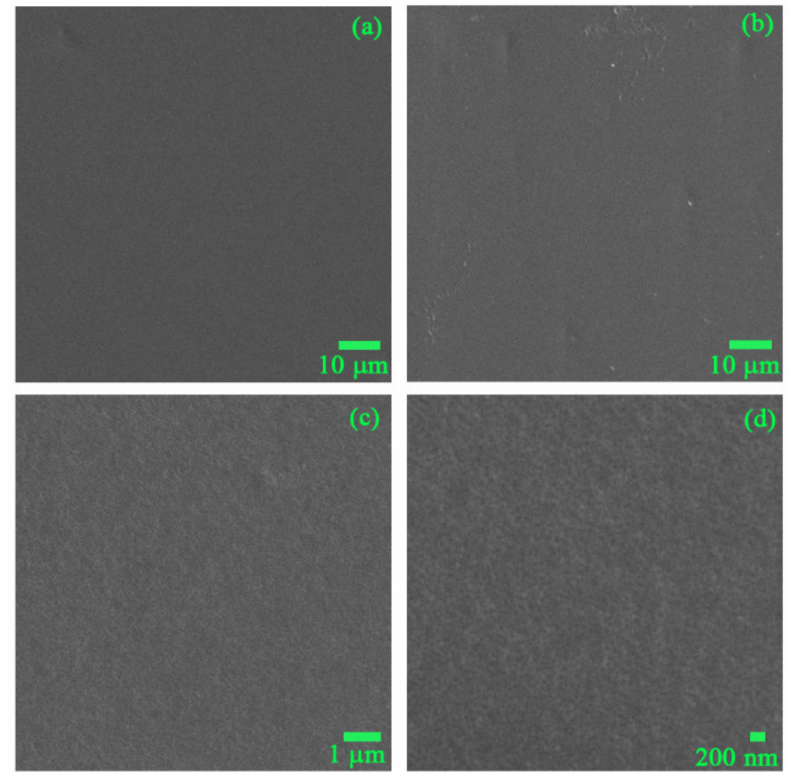
Figure 3. SEM images of ( a ) uncoated PVC, and TiO 2 -coated PVC at different magnifications: ( b ) × 500, ( c ) × 5000, and ( d ) ×